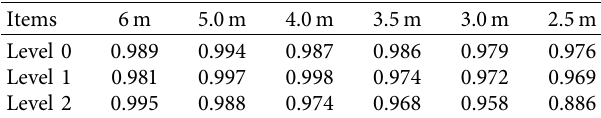
Table 9: Test results of arch bridge (crosswind, side).